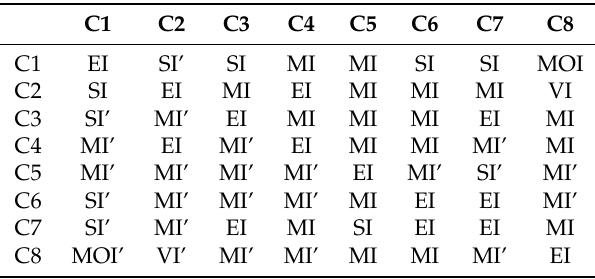
Table 4. Relative importance of each pair of the considered criteria (linguistic